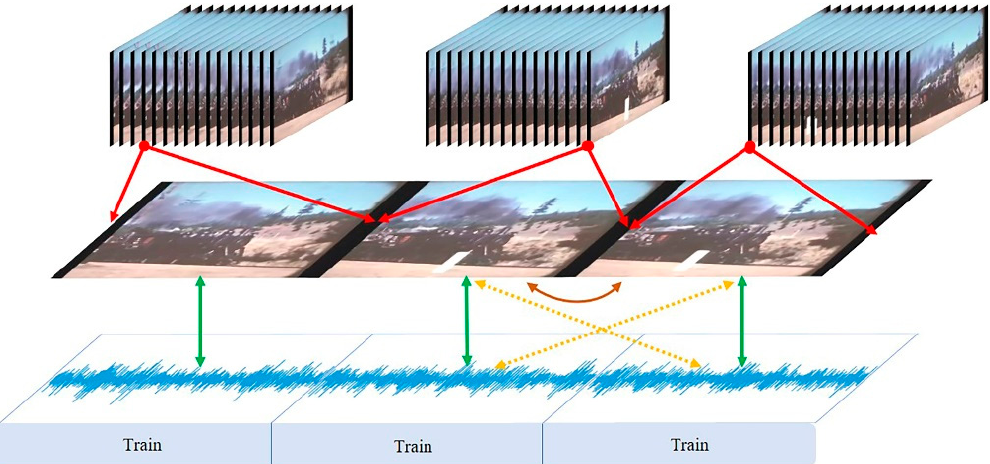
Figure 3. An illustration of the random sampling technique in AV‑BT. Three continuous video segments segments that contain the “train horn” are depicted in this example. The random